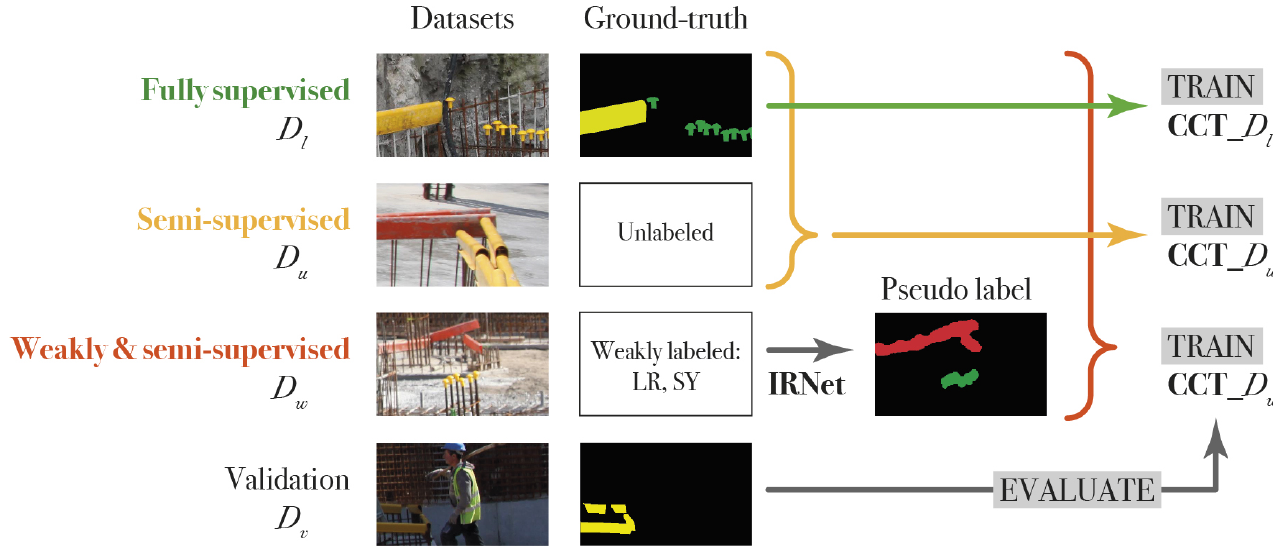
Figure 3. The training setup for the cross-consistency models. Four different CCT models are trained: a fully-supervised baseline CCT_ D l , a semi-supervised model CCT_ D u and two weakly- and semi-supervised models CCT_ D w with a regular crop size of 320 320 pixels and 304 504 pixels. All models are evaluated on D v . × ×